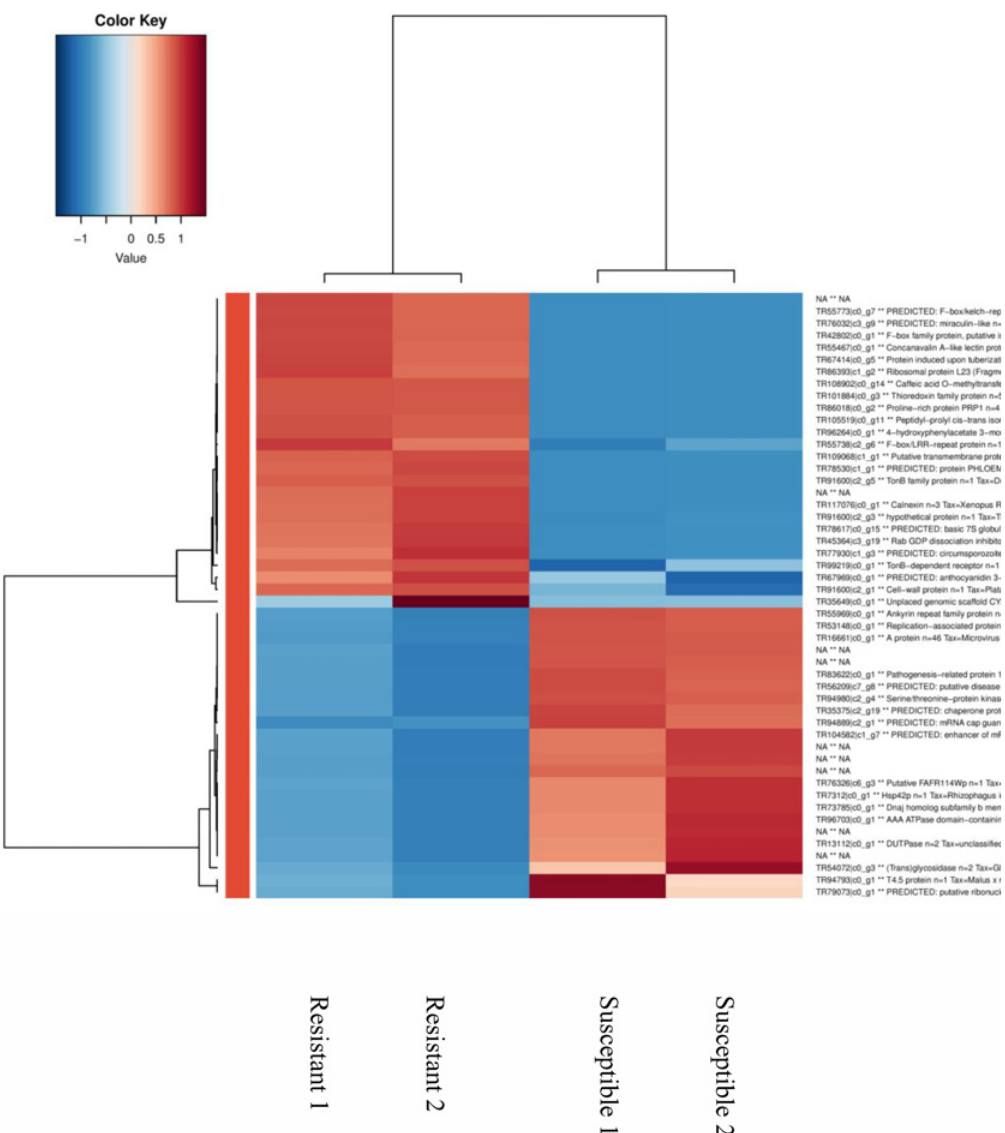
Fig 10. Top 50 differentially expressed genes between nickel-treated resistant and susceptible Betula papyrifera genotypes based on logFC. The red colour represents an upregulation and blue